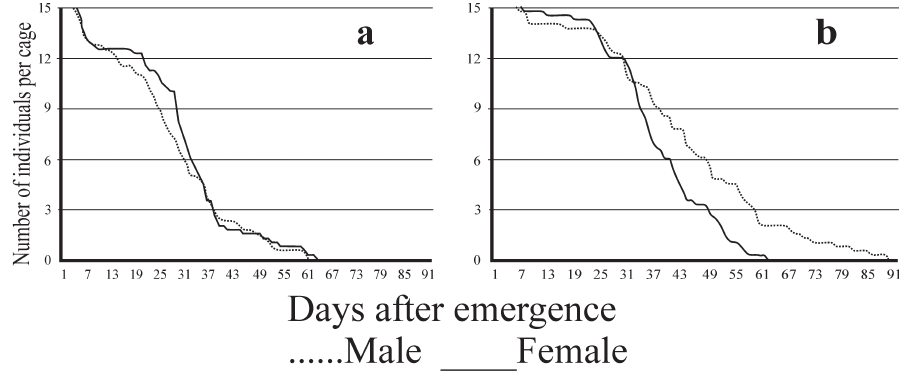
Figure 2 - a : Longevity curve of males and females of Cochliomyia macellaria . b: Longevity curve of males and females of Chrysomya